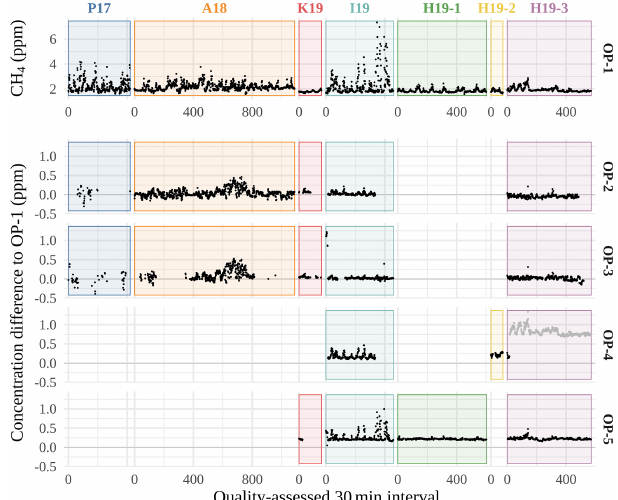
Figure 3. CH 4 concentrations recorded by OP-1 (30min averages) and the corresponding differences to OP-2, OP-3, OP-4 and OP-5. Grey dots: data from device OP-4 during the campaign H19-3 that passed the quality check but have been omitted in the analysis due to an obvious jump in the